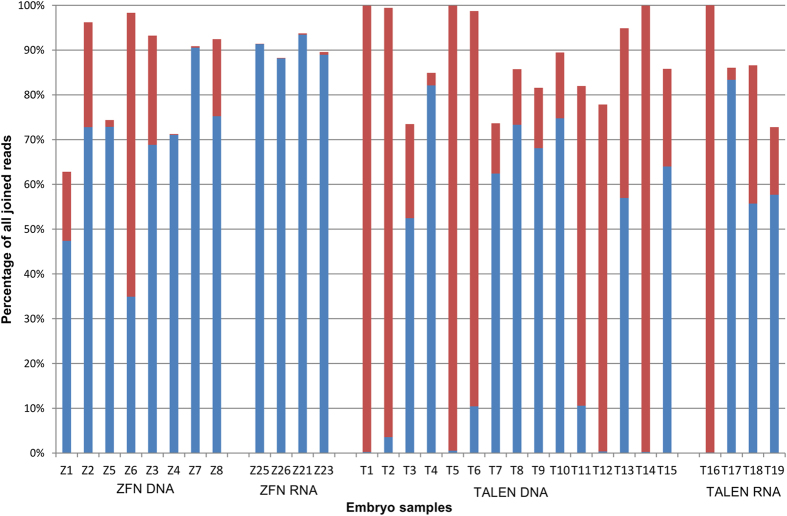
Deep sequencing analysis of ODN 986 co-injected embryos.Selected embryos derived from both ZFN/ODN 986 and TALENs/ODN 986 co-injections were analyzed for the presence of ODN-triggered genome edits and wild type sequencing reads. The representation of alleles with an ODN 986-specified 9 bp deletion (red) and combined wild type alleles A and B (blue) are depicted as percentage of all joined paired end sequence reads for individual embryos injected with DNA- or RNA-encoding ZFNs or TALENs as indicated. The underlying values used to generate the graph can be found in Table S2. Total percentages markedly below 100% denote the presence of additional sequence variants that are not included in the figure and are detailed in Table S1.